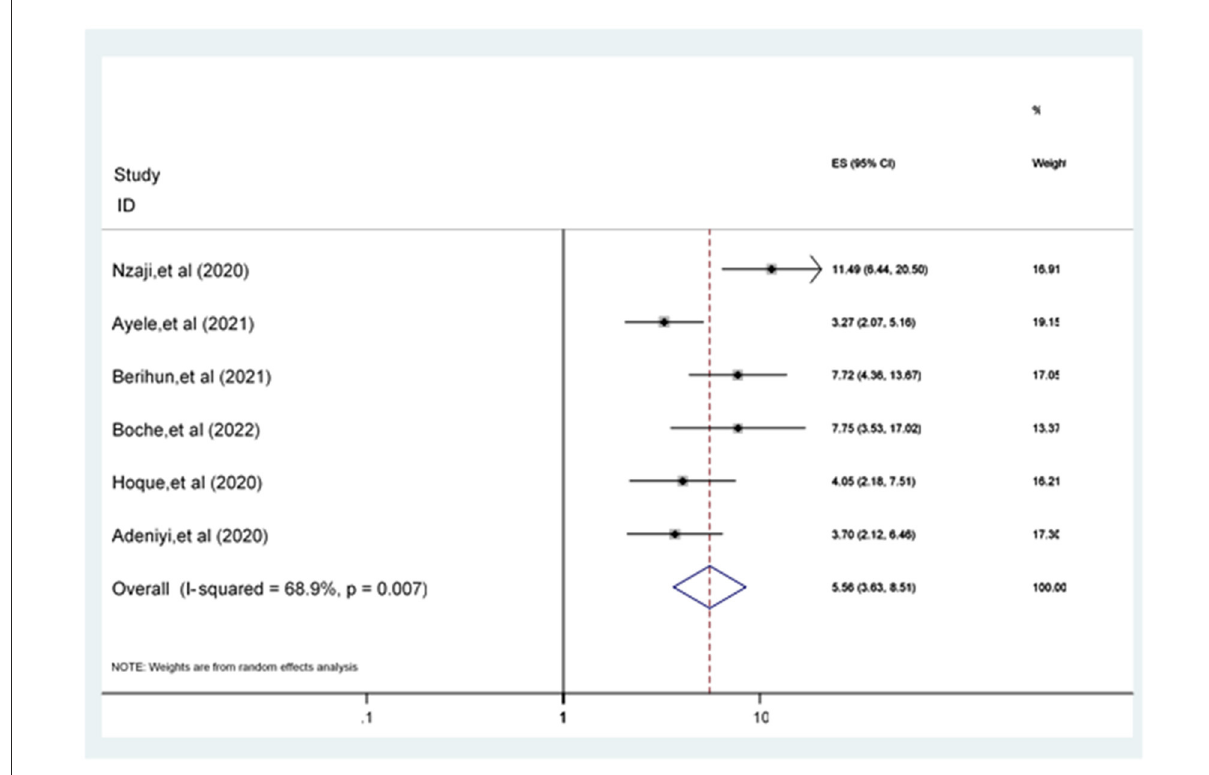
FIGURE7 Forest plot revealing the relationship between attitude and COVID-19 vaccine acceptance among the study population.